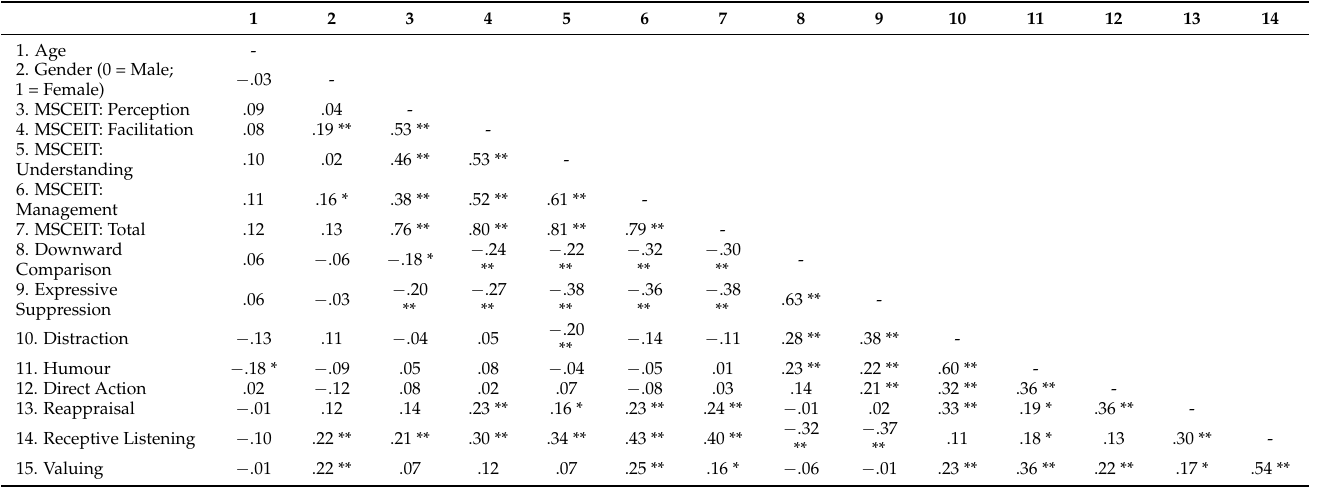
Table 2. Bi-variate correlations between study variables (N =